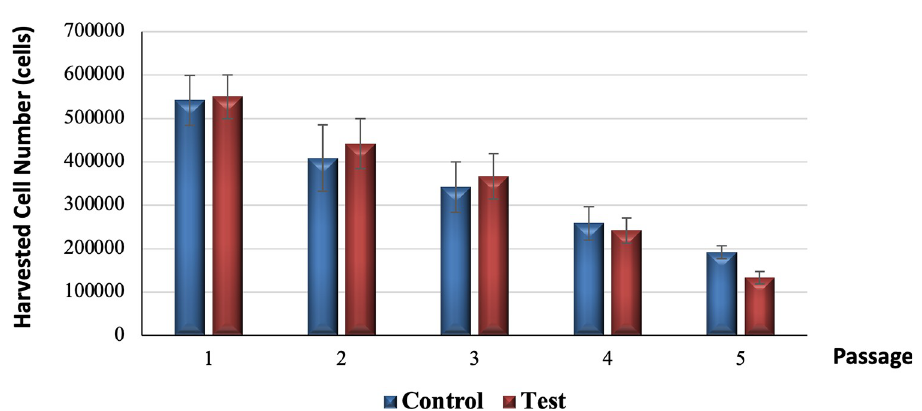
Fig 3. Harvested cell numbers of all five passages between control and test groups.